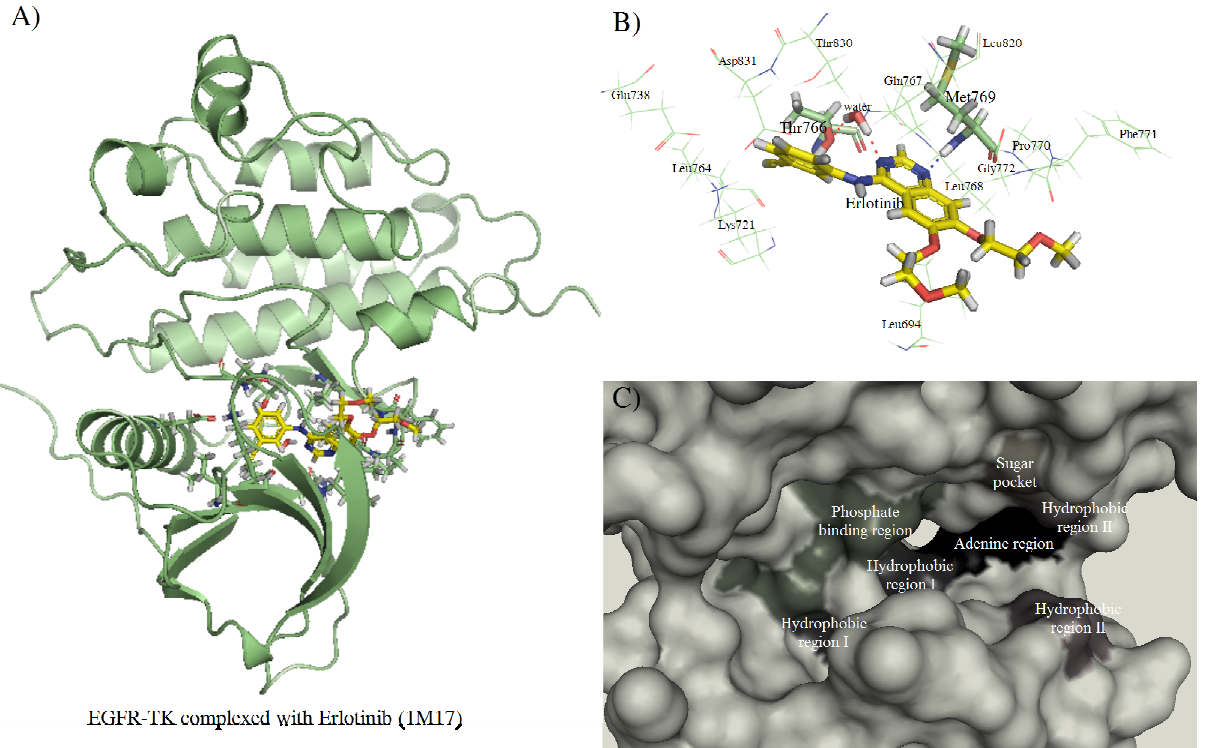
Figure 4. The complexes of EGFR-TK and erlotinib. (A) Overall structure of TK complexed with erlotinib. (B) The erlotinib and binding residues of kinase domain. (C) The molecular surface representation of the ATP-binding region which consists of adenine region, hydrophobic region I and II, sugar pocket and phosphate binding